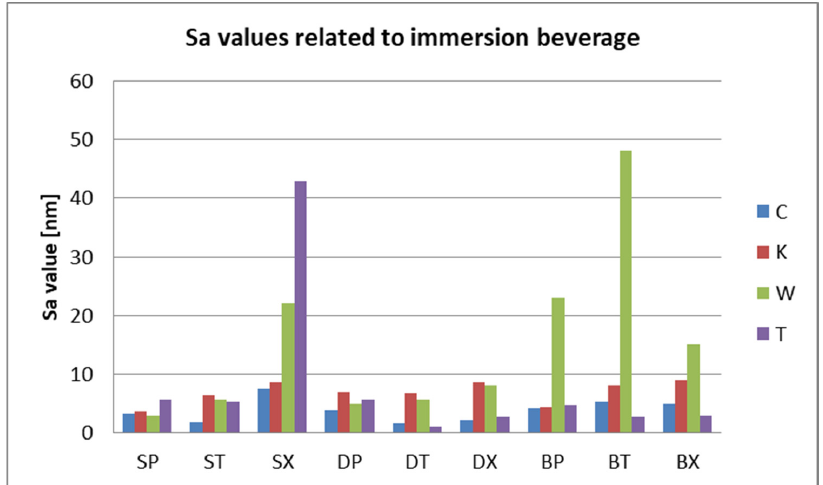
Figure 16. Sa values related to the immersion beverage.